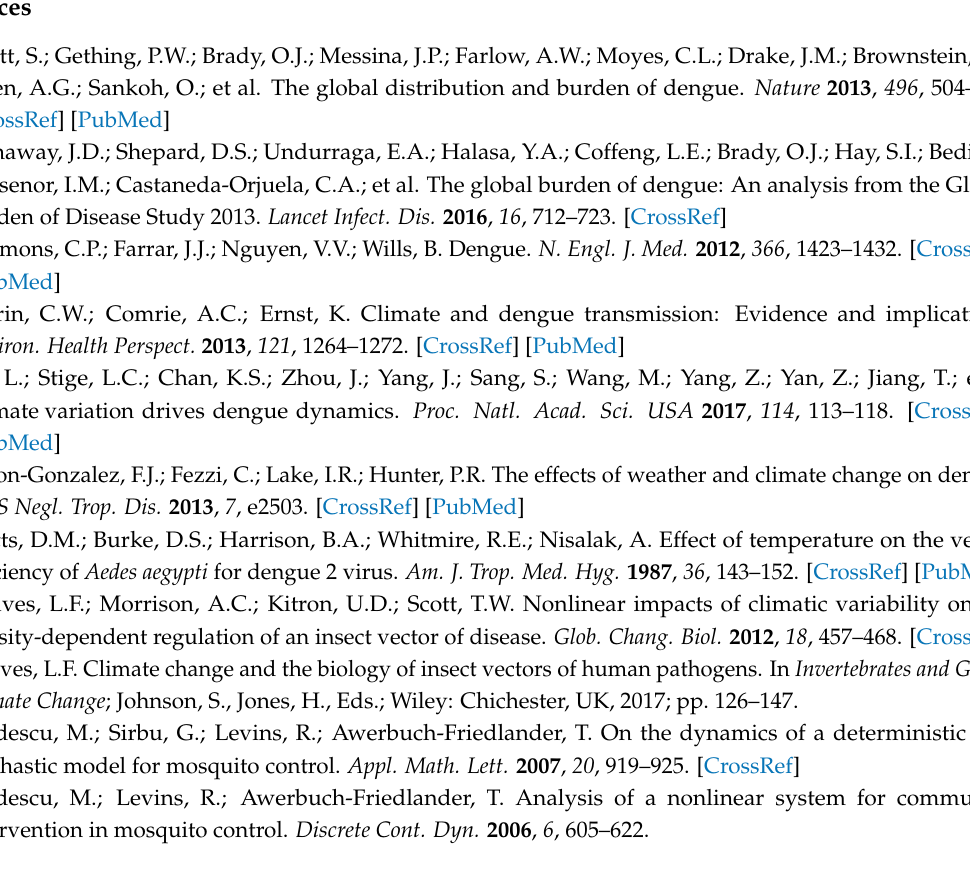
Figure S1: LCLU percentages within the 2nd level dissemination area in the metropolitan region of Tainan City, Table S1: The selected LCLU types in the analysis. Acknowledgments: This study was funded by the Taiwan Ministry of Science and Technology (MOST 104-2119-M-